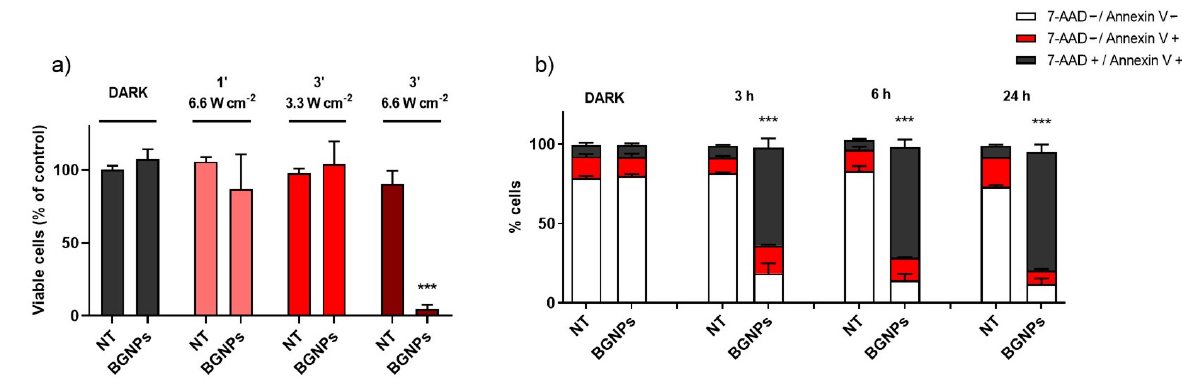
Figure 5. PTT treatment in colon cancer cells. ( a ) Percentage of viable cells (MTT) incubated with or without BGNPs, in dark condition or irradiated for different times and laser irradiance determined by MTT test. Percentage of viable cells is normalized on not treated (NT) cells in dark. ( b ) The percentage of living cells (white), cells undergoing programmed cell-death (red), and necrotic cells (black) after incubation or not with BGNPs in the dark or 3 h, 6 h, and 24 h after 3 min of irradiation at 6.6 W cm − 2 . Data are the mean values of at least three independent experiments. *** p < 0.001 versus non-treated (NT) cells.